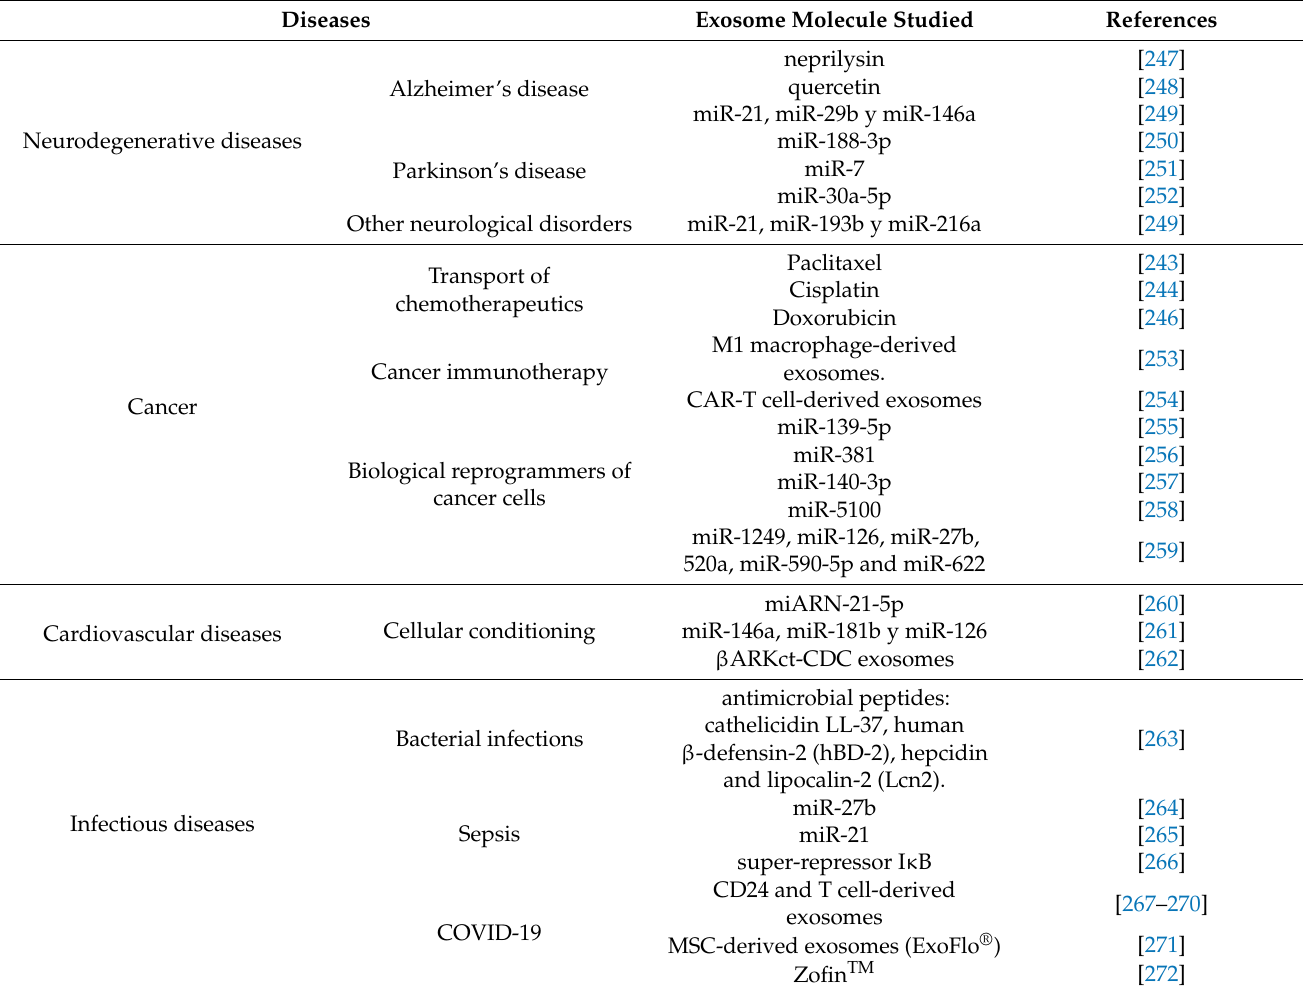
Table 3. Recent studies describing the potential role of exosomes in the treatment of